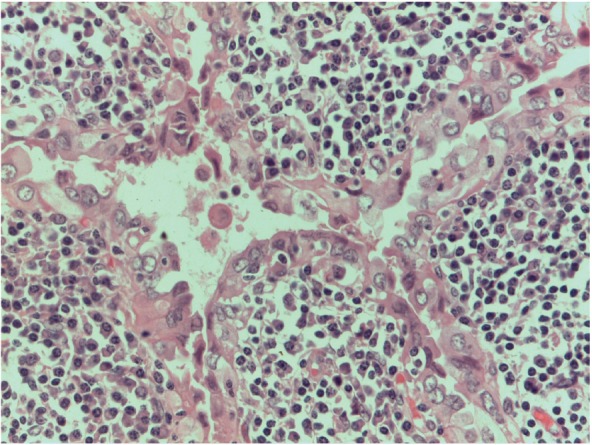
Papillary carcinoma Warthin-like cytoarchitectural features particular x400 magnification.